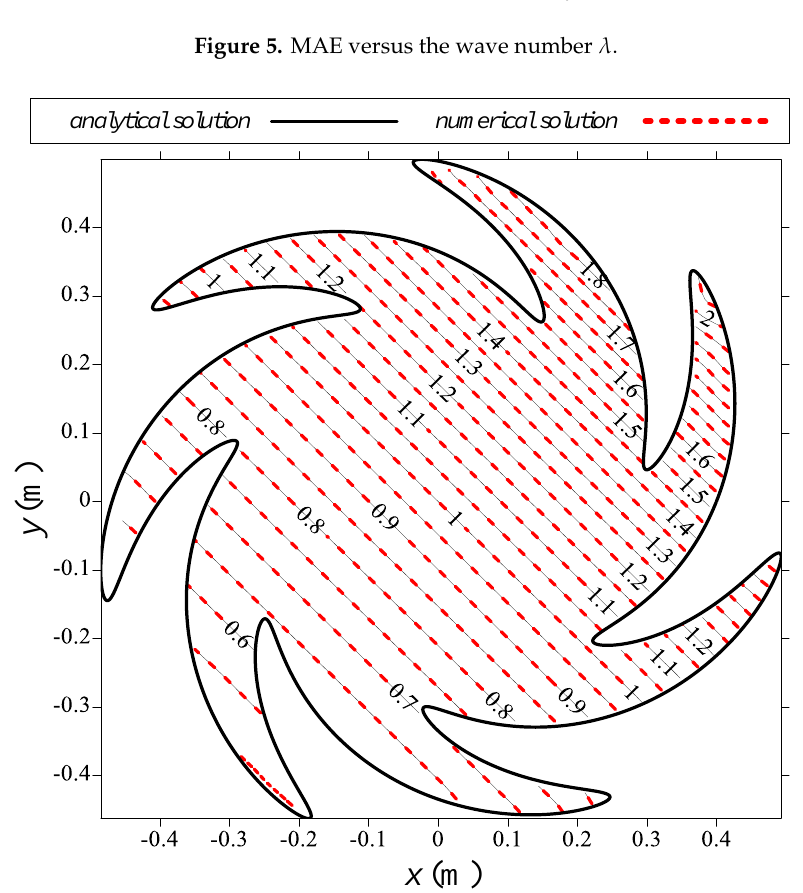
Figure 6. Results comparison with the exact solution.